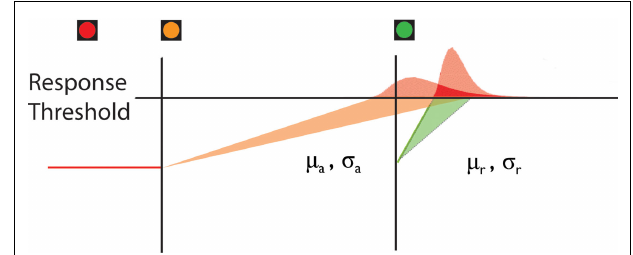
FIGURE 2 |Two-horse linear rise-to-threshold model of response time data in theTraffic Light task. Group and individual response time data were fit to a two-horse linear rise-to-threshold model. Response time distributions arise probabilistically from one of two linear rise-to-threshold processes, and the first process to reach the threshold (horizontal line) on a given trial will trigger a response: (1) An anticipatory decision process, triggered by the onset of the amberTraffic Light, with mean rate of rise μ a and SD rate of rise σ a .This process has a small mean rate of rise and large variance, and therefore results in a wide distribution of RTs, of which some are elicited prior to green. (2) A reactive decision process, triggered by the onset of the greenTraffic Light, with mean rate of rise μ r and SD rate of rise σ r .This process has a high mean rate of rise and small variance, and therefore results in a narrow distribution of RTs with median shortly after green